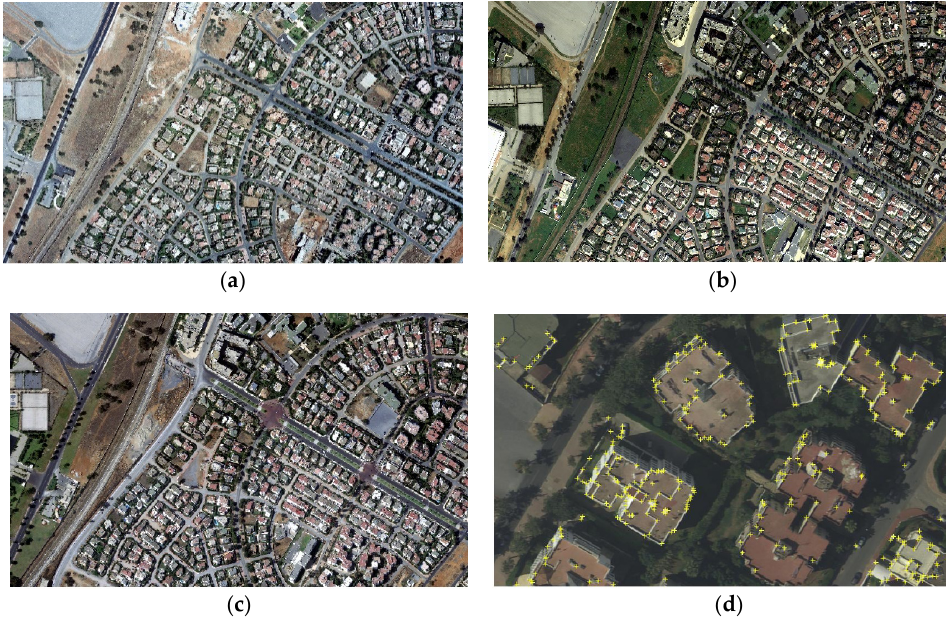
Figure 2. Aerial photography used in the experiments: ( a ) reference image acquired in 2009, ( b ) sensed image acquired in 2014, ( c ) sensed image acquired in 2016, ( d ) sensed image with Harris